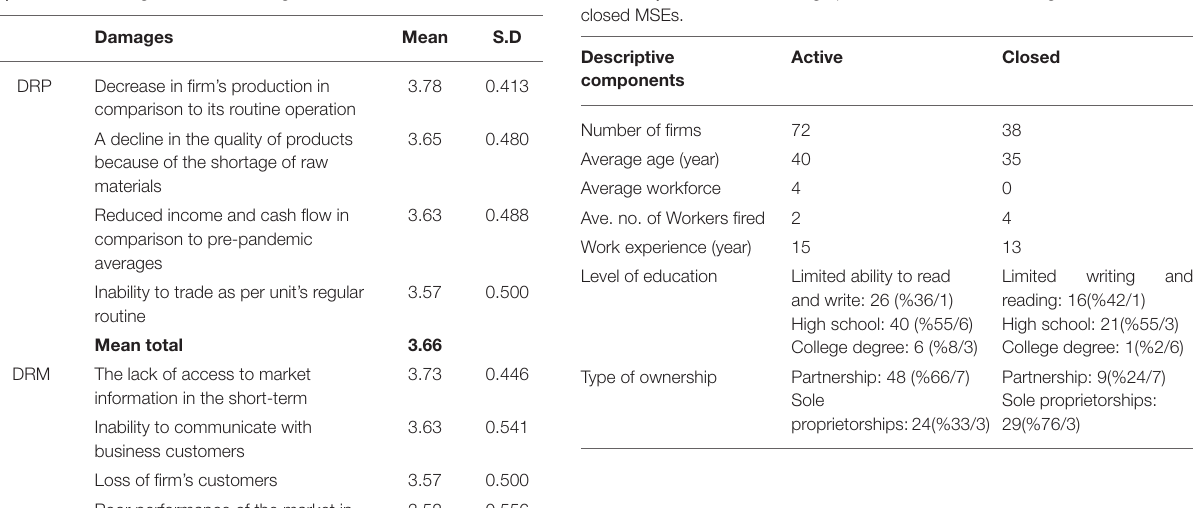
TABLE 3 | Mean and ranking of different damages in closed MSEs. TABLE 4 | Personal and demographic characteristics of managers in active and